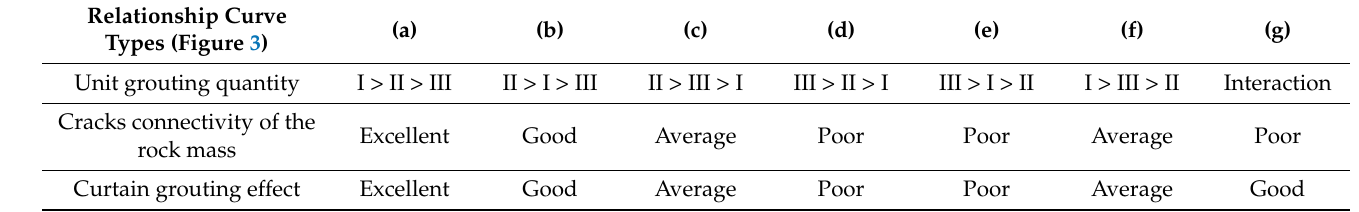
Table 2. Interpretation of relationship curves of unit grouting quantity of each sequence hole and grouting